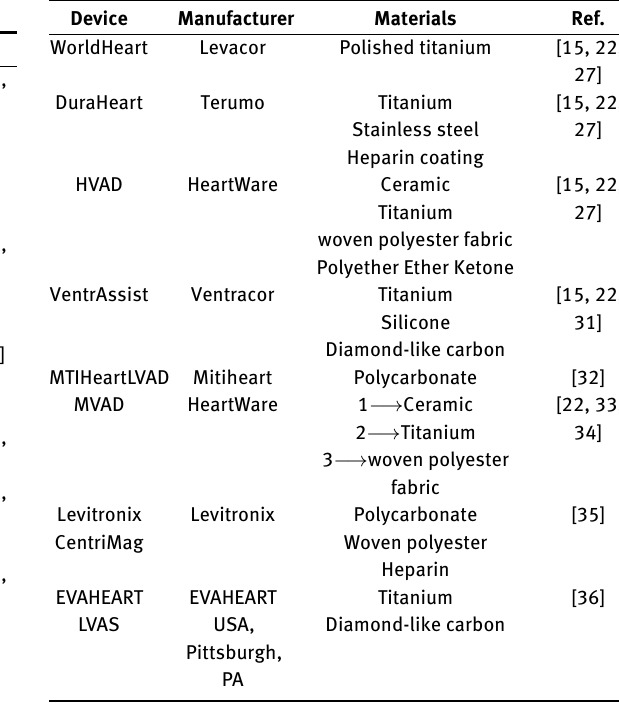
Table 2: The clinical implantable of axial heart pumps.